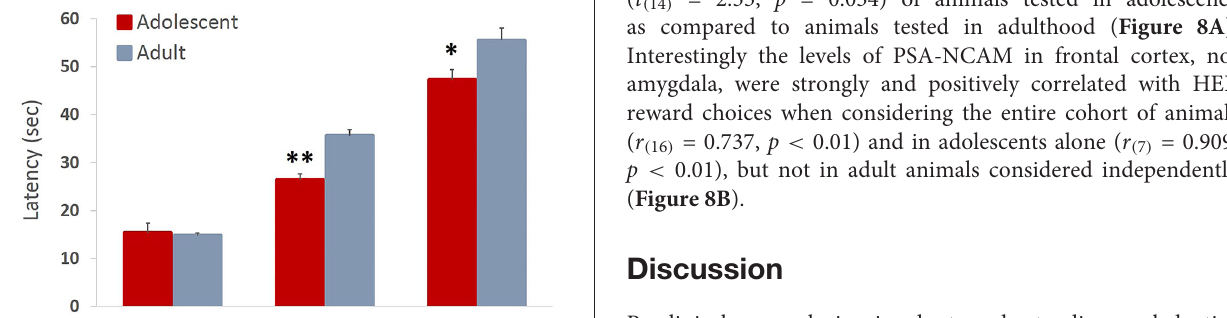
FIGURE 7 | Dopamine D1 and D2 receptor expression in adolescent and adult animals . The bar graphs represent the concentration of D1R (A) and D2R (B) protein (ng/mg of total protein) + SEM. (A) D1R expression was non-significantly increased in frontal cortex and significantly reduced in striatum